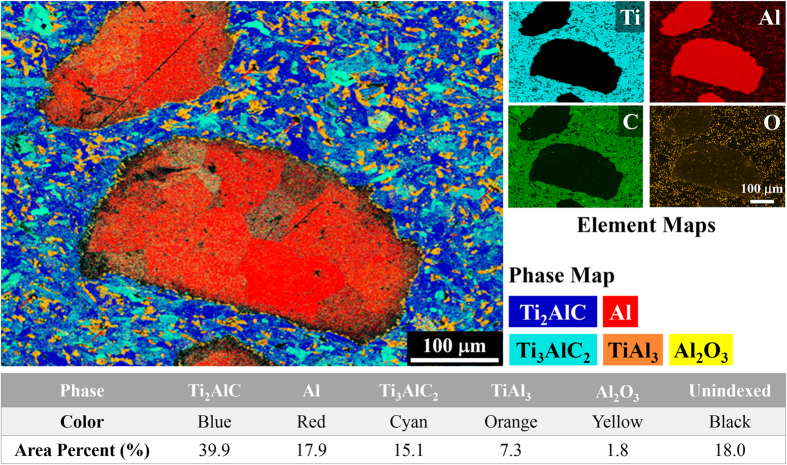
A phase map and four element maps, namely Ti, Al, C, and O, of the Al alloy/Ti2AlC (volume ratio 40/60) composite with the size of the Al alloy phase ranging from 167 to 54 μm.Both identified and unindexed phases are color coded in the phase map; 82.0% of all phases were identified, and 18.0% were not identified. The identified phases include Ti2AlC, Ti3AlC2, Al, TiAl3, and Al2O3; the area percent of each phase is listed in the table. Red arrows point to some of the unidexed phases.